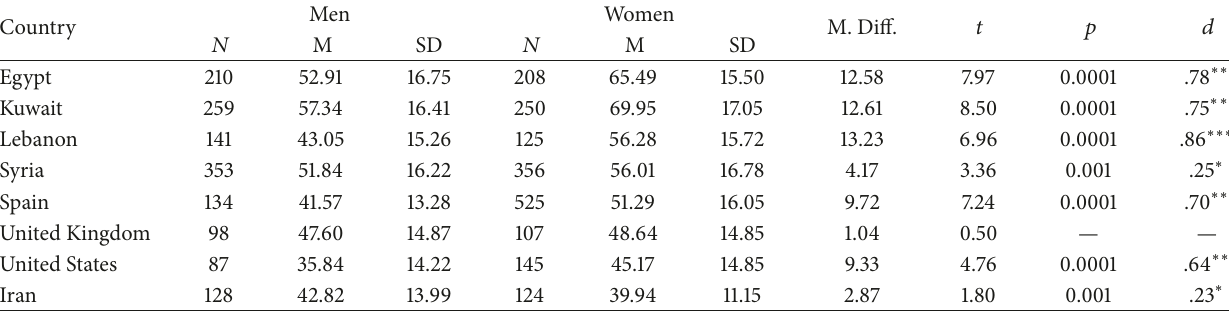
Table 4: Descriptive statistics of the Arabic Scale of Death Anxiety (ASDA) in college students from eight Arab, Western, and Iran countries. Men Country